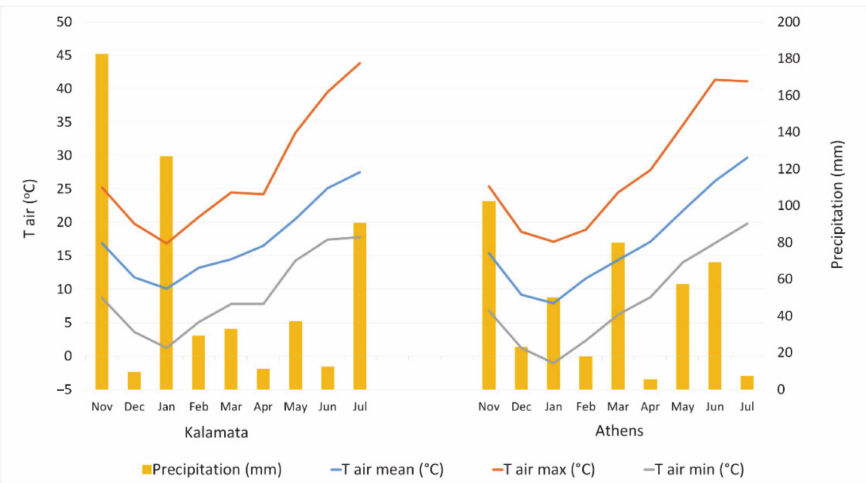
Figure 2. Mean, max and min monthly air temperature ( ◦ C) and precipitation (mm) for Kalamata (left) and Athens (right) during the growing period (November 2016 to July 2017). The experiment was arranged in a Randomized Complete Block Design (RCBD) with three replicates. Plants were spaced at 30 cm between rows and 25 cm apart within the row forming 2.25 m 2 experimental plots. Plants were cultivated in a loam soil, with a pH value of 7.6 and a CaCO 3 content of 15.47% in Kalamata field. On the other hand, in Athens field plants were cultivated in a silt clay loam soil, with corresponding values for pH and CaCO 3 , 7.9 and 17.47% (Table 1). Table 1. Soil traits of the experimental fields in Athens and Kalamata locations.